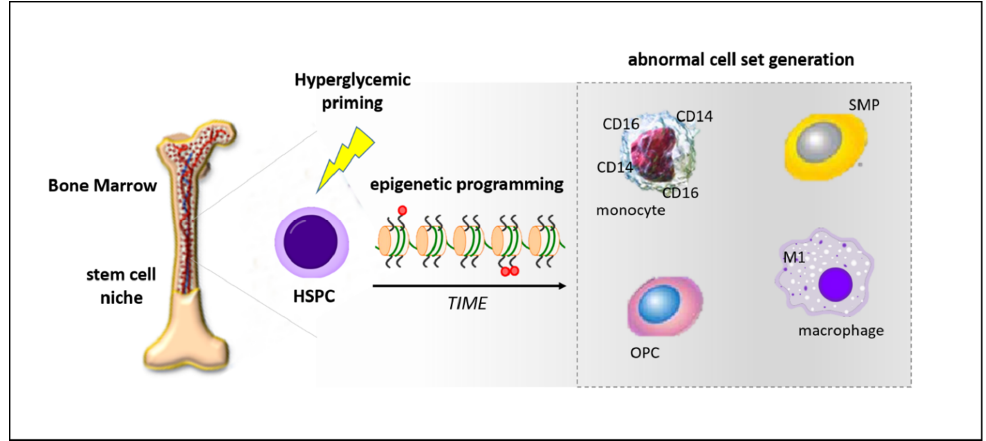
Figure 2. Schematic representation of hyperglycemia-induced programming of hematopoietc stem progenitor cells (HSPCs) at the bone marrow level. Diabetic milieu promotes epigenetic changes in HSPCs that result in the abnormal expansion of cells with inflammatory and pro-atherosclerotic features, such as intermediate monocytes (CD14+CD16+), M1 macrophages, osteoprogenitor cells (OPCs), and smooth muscle progenitors (SMPs).